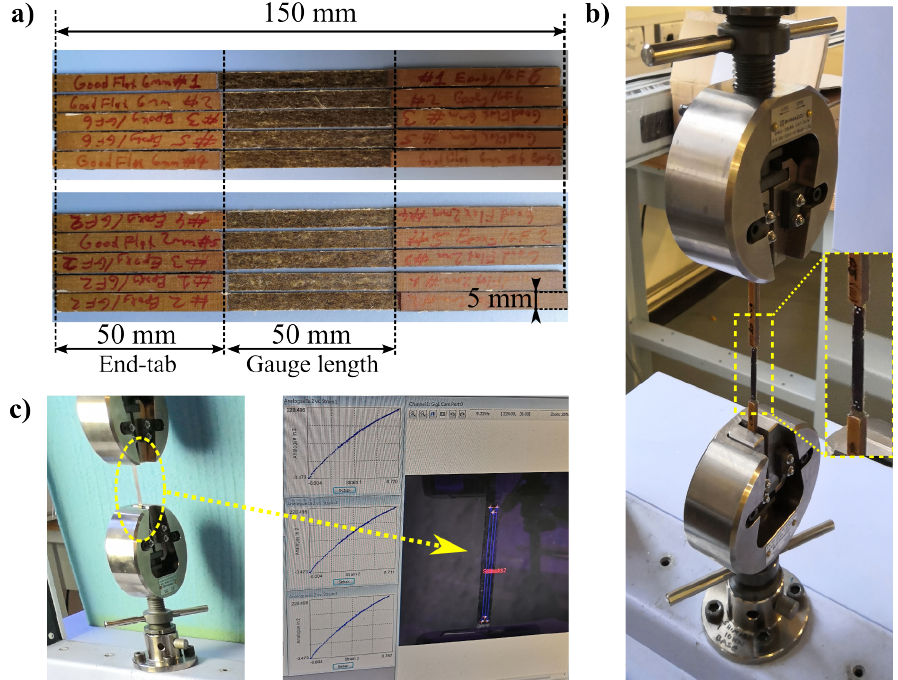
Figure 3. ( a ) Top view of ADNFRC specimens (2 mm and 6 mm flax-ft epoxy composites) and their geometry, ( b ) the tensile test rig with specimen magnified, ( c ) the specimen during measurement and the resulting image on video